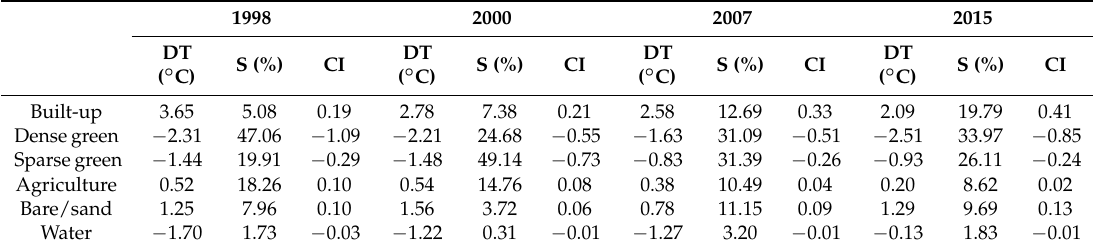
Table 4. Changes in the heat source/sink role of land use and land cover types in Bo town between 1998 and